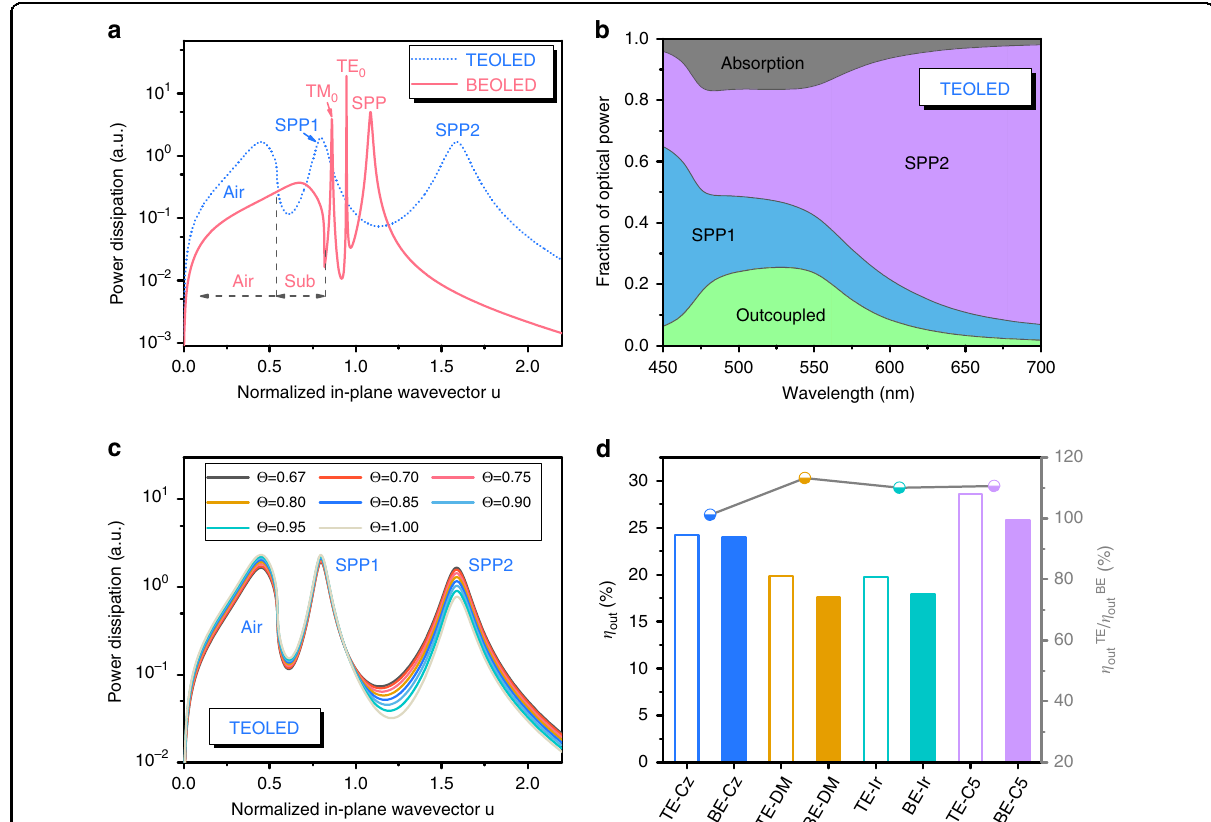
Fig. 3 Power dissipation spectra and outcoupling ef fi ciencies of OLEDs with weak microcavities. a Power dissipation spectra at λ = 540 nm for the conventional devices and the top-emitting devices, the in-plane wavevector u is normalized with respect to propagation in the emitting layer. b Distribution of all optical loss channels in the top-emitting devices. c Power dissipation spectra of organic emitters with different horizontal dipole ratio Θ in the top-emitting devices. d Outcoupling ef fi ciency η out of the top-emitting devices and the conventional devices, and their ratios η outTE / η outBE